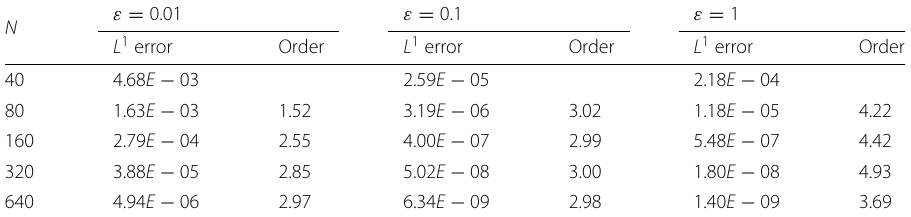
IMEX-ARS3 WCNS at t =